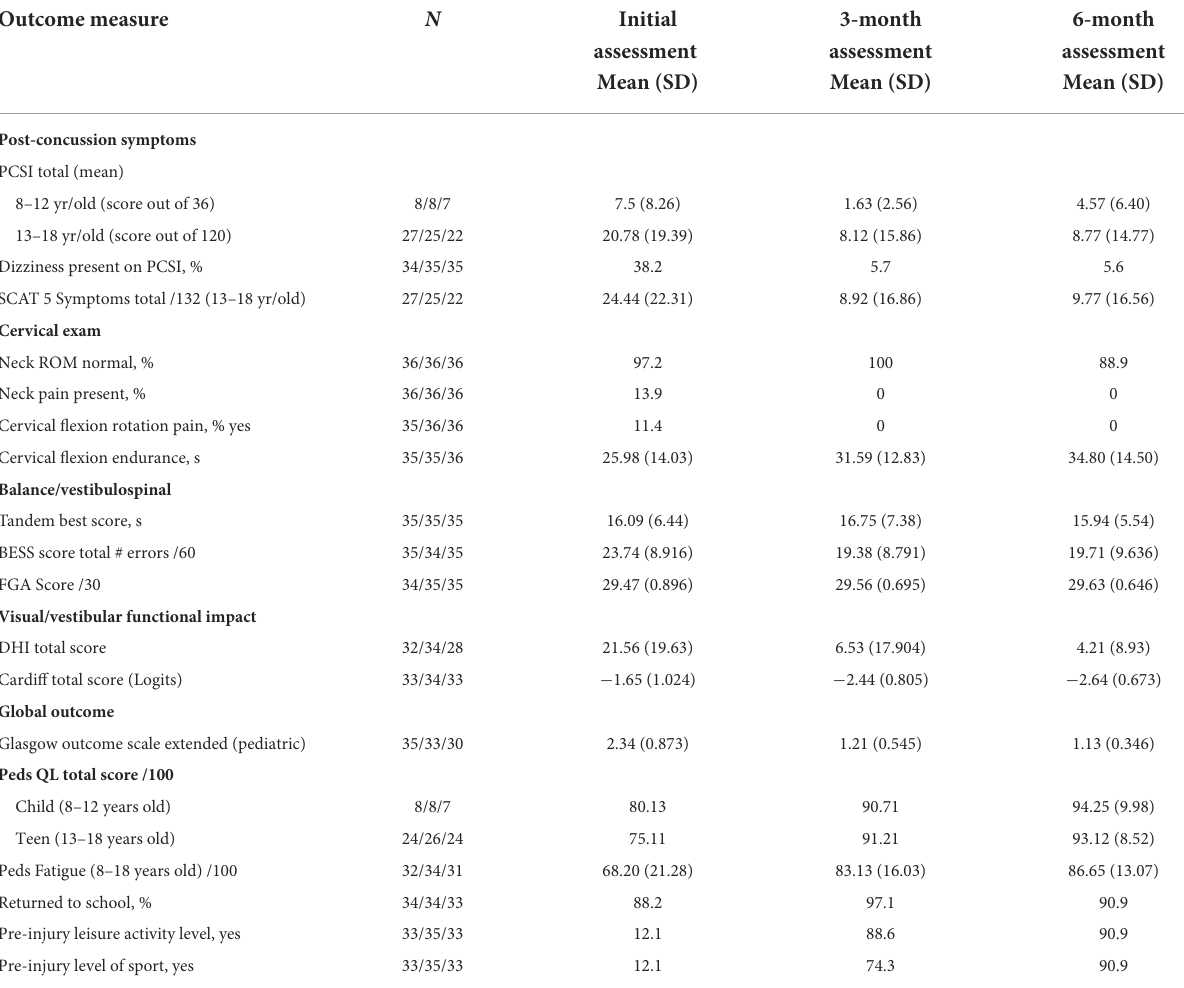
TABLE 3 Post-concussion symptoms, cervical, balance, functional and global outcome measures over time (see Supplementary Table 1, for explanation of outcome measures). Outcome measure N